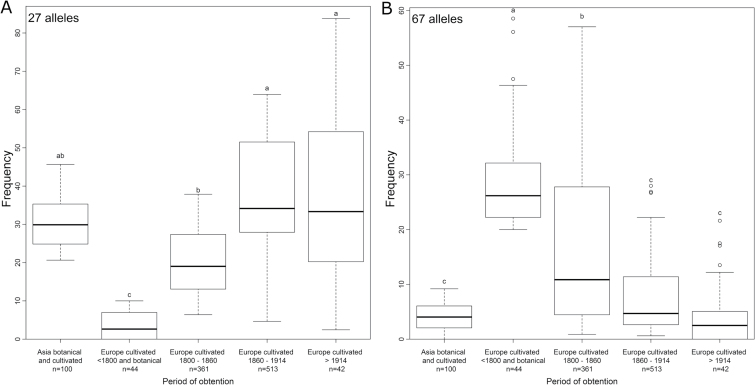
Evolution of the frequency of occurrence of the alleles in the sample. The boxplots show the median and the box delimits the interquartile interval. The letters represent the result of a Tukey’s HSD test comparing each group of individuals (P<0.01). n, number of individuals in this period. (A) Alleles present at a high frequency (>20%) in roses from Asia and at a null or low frequency (<10%) in European roses bred before 1800. (B) Alleles present at a high frequency (>20%) in European roses bred before 1800 and at a null or low frequency (<10%) in roses from Asia.